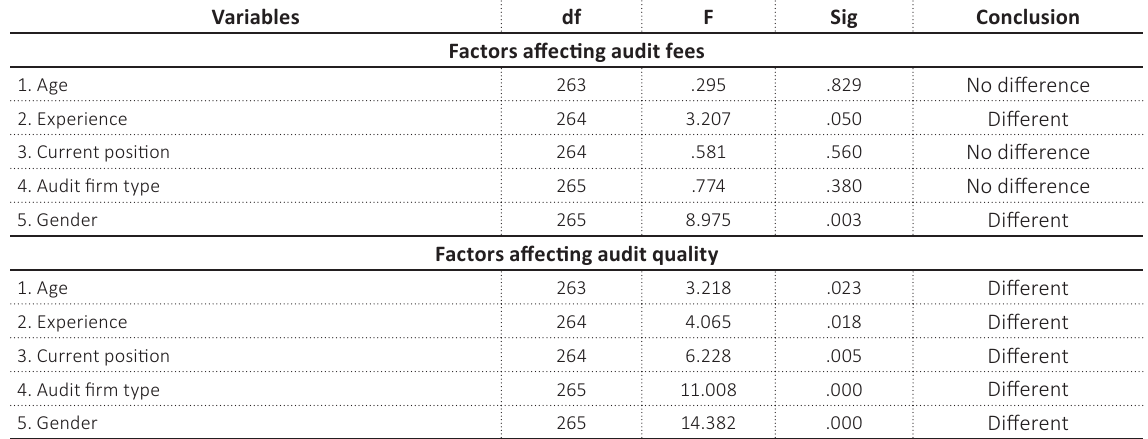
Table 6. Testing the sample differences using ANOVA